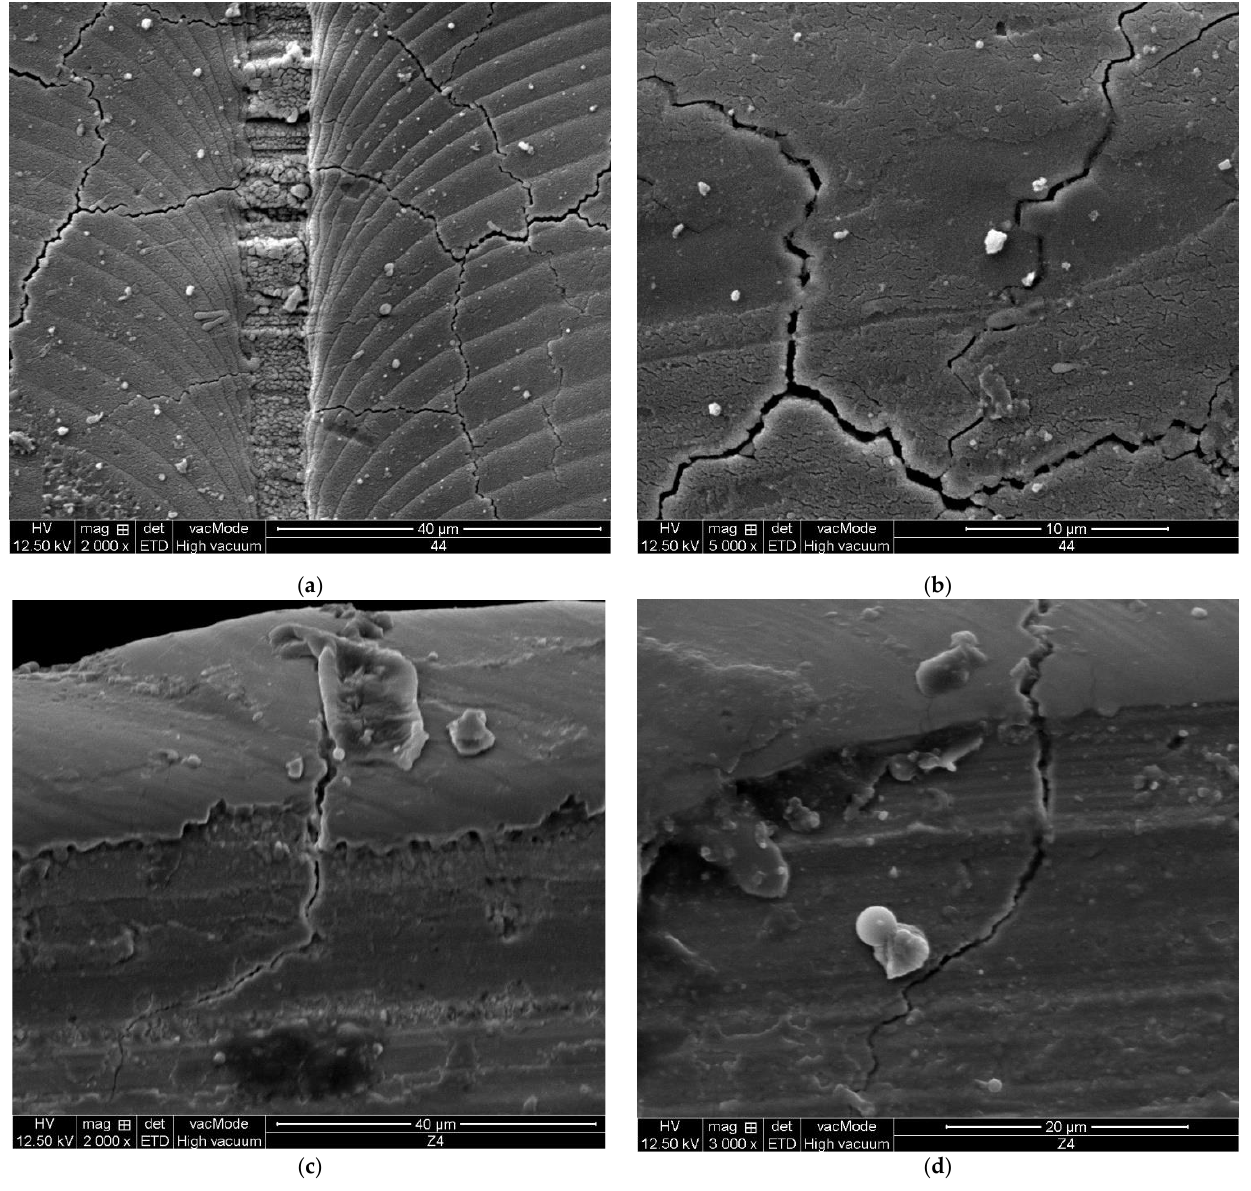
Figure 6. SEM microtopography of cracks on lasered zirconia workpiece ( f = 49 kHz, V = 100 mm/min, S 1 = 100 μm, N = 1). ( a ) Lateral cracks. ( b ) Lateral cracks (Enlarged). ( c ) Median crack (Position 1). ( d ) Median crack (Position 2).